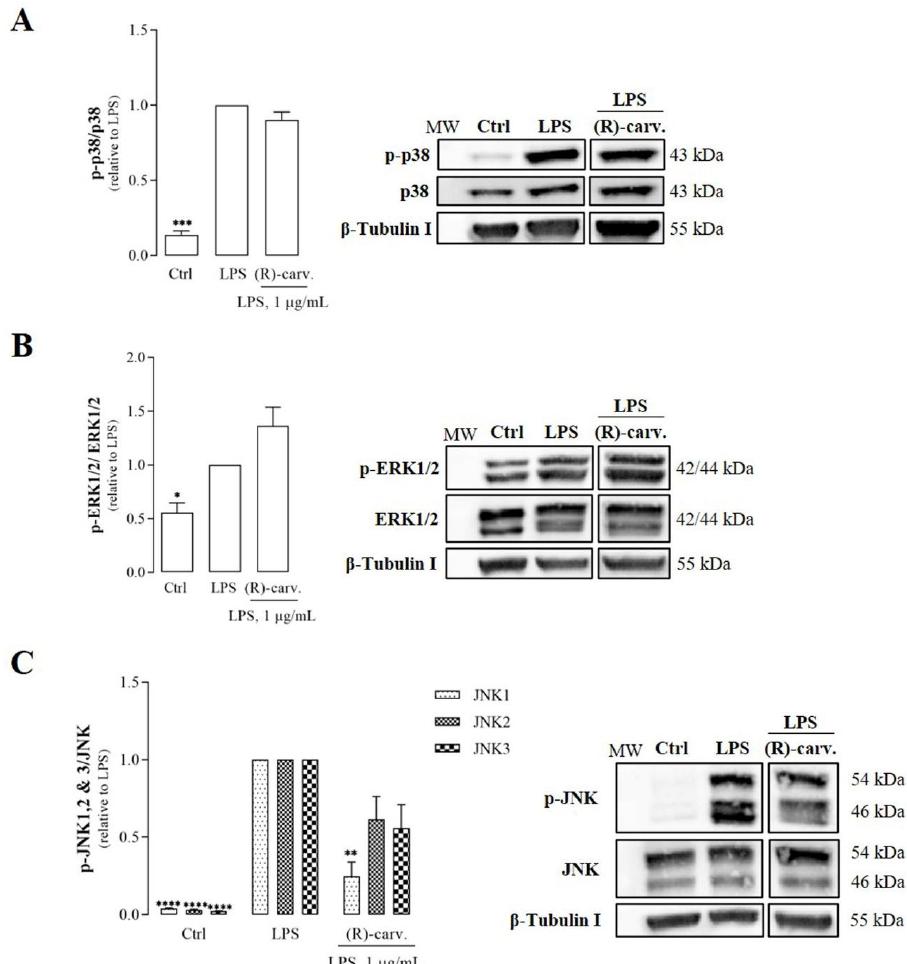
Figure 2. Effect of (R)-(-)-carvone on p38 ( A ), ERK1/2 ( B ) and JNK ( C ) phosphorylation induced by LPS in RAW 264.7 cells. Macrophage cultures were pre-treated with 665 µ M of (R)-(-)-carvone or with the vehicle (0.1% DMSO) for 1 h and then with 1 µ g/mL LPS for 5 min ( A , C ) or 1 h ( B ). Control cells (Ctrl) were treated with the vehicle (0.1% DMSO) in the absence of LPS. Each column represents the mean ± SEM of four ( A , C ) or three ( B ) independent experiments. Supplementary Table S1 show the raw data of the results presented in panel C. Representative images are shown. The corresponding images of the full-length blots are shown in Supplementary Figure S1. * p < 0.05, ** p < 0.01, *** p < 0.001 and **** p < 0.0001 relative to LPS-treated cells. MW: molecular weight